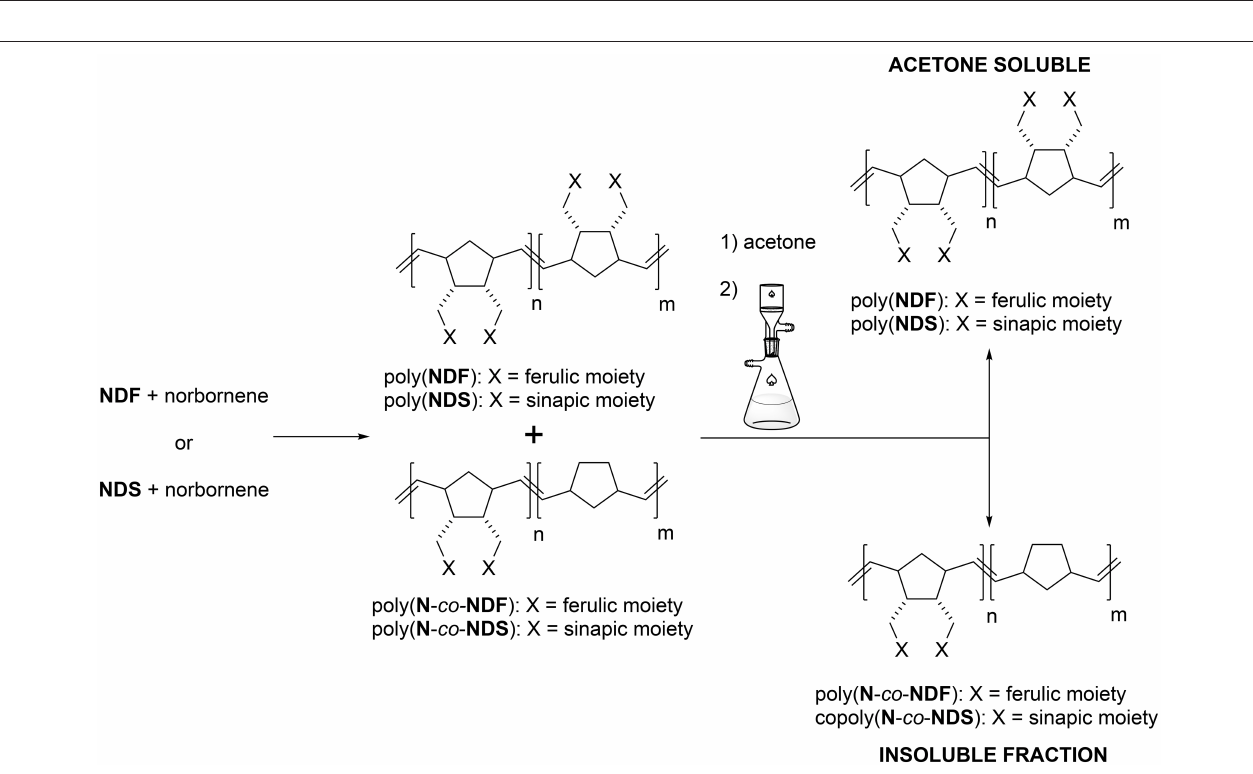
FIGURE 3 | GPC traces of crude copolymerization (red), acetone-soluble polymers (blue) and acetone-insoluble polymers